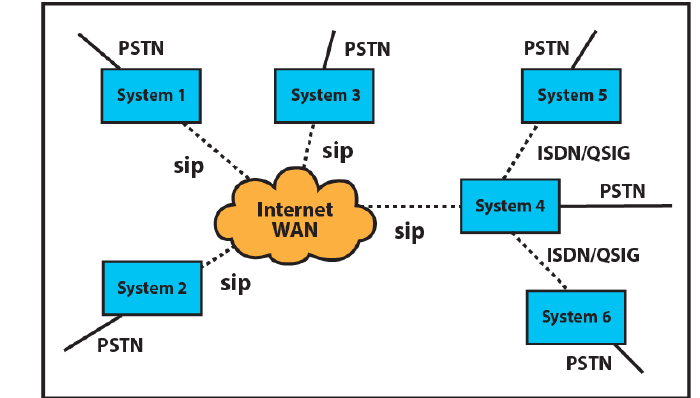
Figure 6 – Principle of the organization of homogeneous PATN with the switching systems Mitel MX-ONE, Mitel TSW/MD110 and those of other manufacturers (Mitel Sweden AB, 2018a) Рис. 6 – Принцип организации однородного PATN с коммутационными